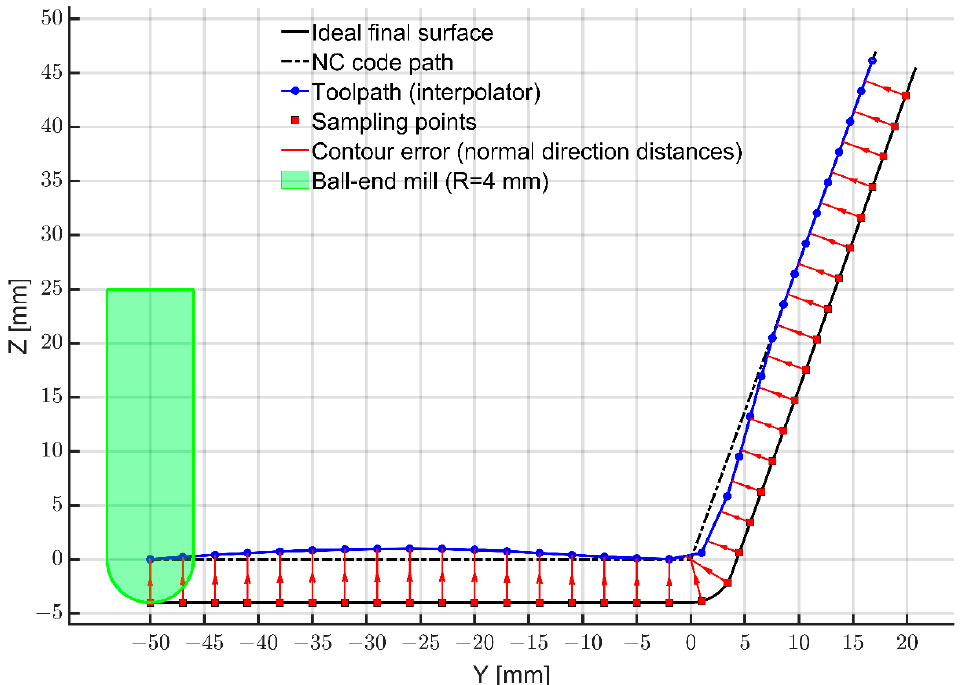
Figure 4. A schematic representation of the contour error evaluation method on a piecewise linear toolpath. The NC code path (dashed black line) is given by the part program, which is either an output of a CAM software, or is computed analytically (as in the case of the testing toolpath presented). In the displayed case, the final surface is a result of moving the tool center point of a spherical milling tool with radius 4 mm along the piecewise linear NC code path. The NC code path serves as an input to the interpolator system. The interpolator system optionally smoothens the toolpath by introducing transition curves and then designs a feedrate profile based on its parameter settings and the geometry of the NC code path. The interpolator toolpath (blue path) is then obtained by sampling the toolpath at a fixed time frequency based on the designed feedrate profile. The magnitude and character of deviations presented in this figure were exaggerated to demonstrate the contour error evaluation